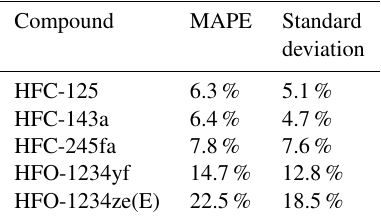
Table 3. The mean percentage error (MAPE) of directly and in- directly calculated mole fractions and the standard deviations of the relative deviations of each data point (direct vs. indirect) for the in situ GC–MS measurements for the period from May 2018 to March 2019 (cf. Fig. 8). As main reference, HFC-152a is used; as evaluation reference, PFC-318 is